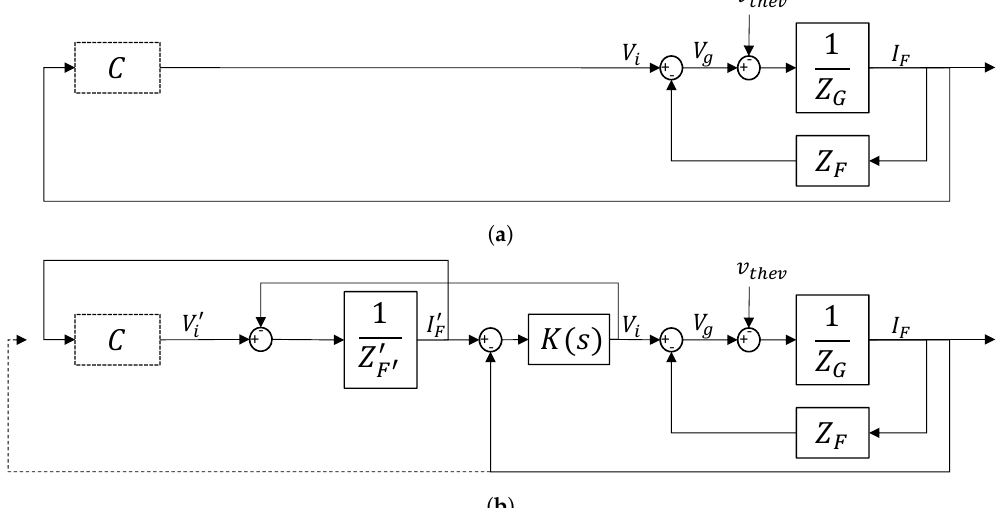
Figure 4. Diagram of the output dynamics seen by the virtual oscillator for voltage-sourced and current-controlled systems. The oscillator controller C is not modified, and is shown with a dashed border. The remainder of the system is shown as a linear transfer function block diagram. The filter impedance is Z F for the hardware filter or Z (cid:48) for the virtual filter. The grid (either G or G (cid:48) ) is treated F (cid:48) as its Thévenin equivalent with impedance Z G and voltage v thev . The current controller (e.g., a PI controller) is K ( s ) . The various impedances are all functions of s . ( a ) Voltage-sourced inverter block diagram. In the base derivation, the virtual oscillator control (VOC) controller C receives a current feedback I F measured at the inverter output. ( b ) Current-controlled inverter block diagram. In the base derivation, the VOC controller C receives a virtual current feedback I (cid:48) based on the virtual filter. F Alternatively, one could use the feedback of the actual current I F , shown as a dashed